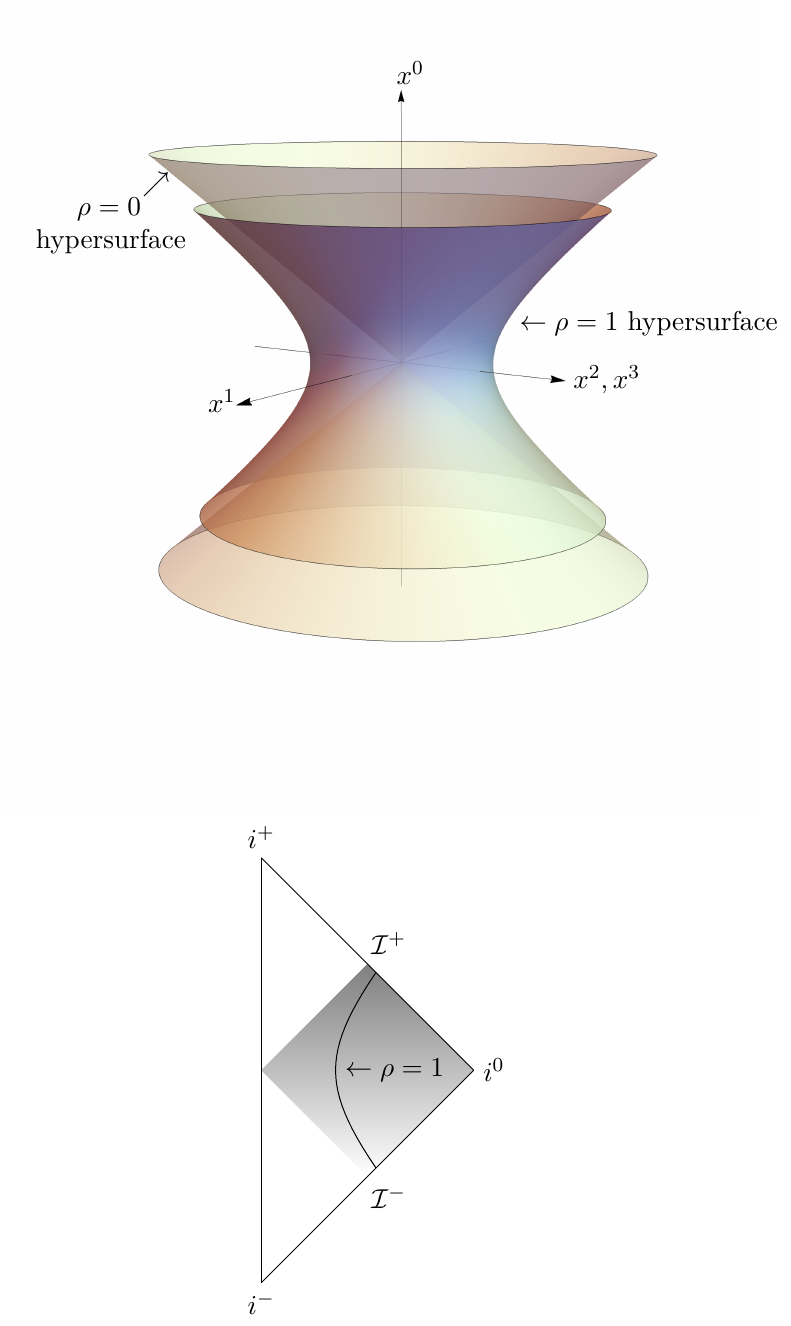
Figure 1 . Minkowski spacetime may be divided up into radial ( ρ ) slices isometric to 3d de Sitter spacetime as shown in the top panel. The bottom panel shows the Penrose diagram of Minkowski spacetime. The shaded region is the region bounded by ρ = 0 and ρ = ∞ . In particular, i ± are excluded from this